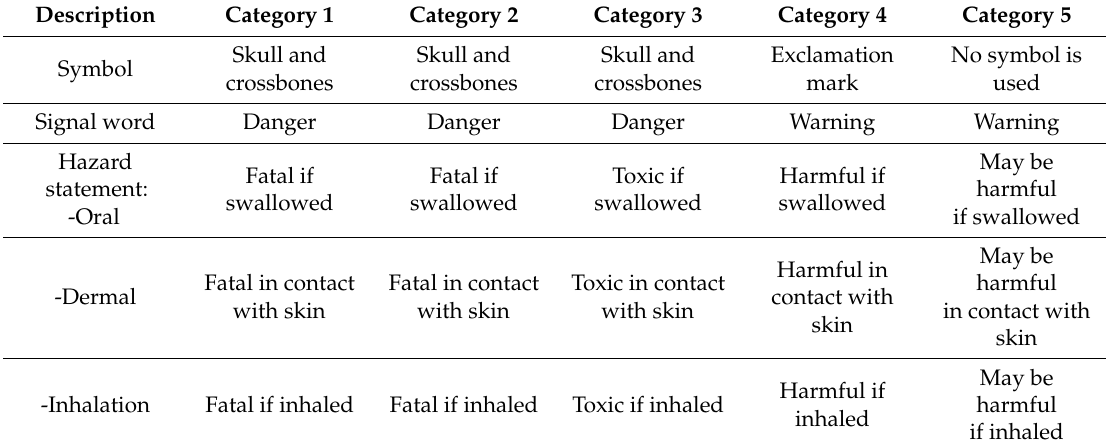
Table 5. Additional information for the